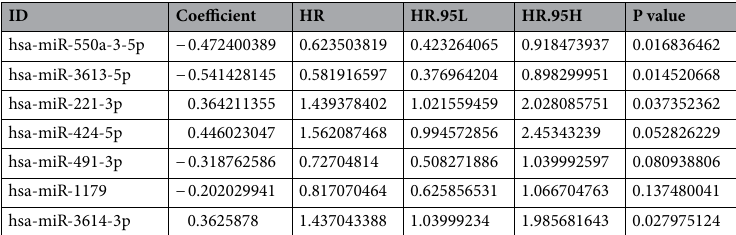
Table 2. Results of multivariate Cox regression analysis of prognostic model.